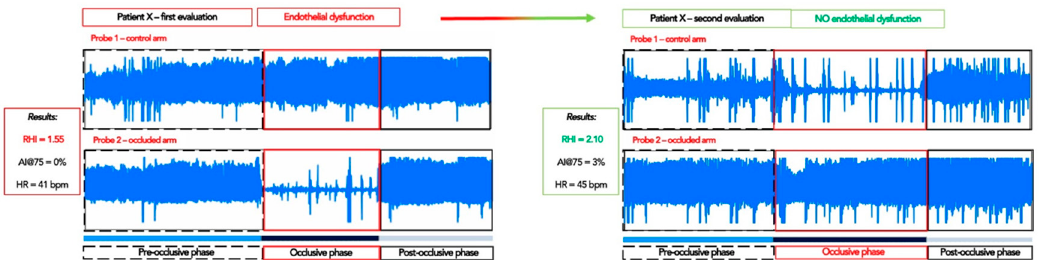
Figure 2. Schematic representation obtained from the EndoPAT analysis: comparison between the first assessment (T0) and the one-year assessment (T1). (RHI: reactive hyperaemia index; Aix: augmentation index; Aix@75: augmentation index corrected for 75 bpm; HR: heart rate).